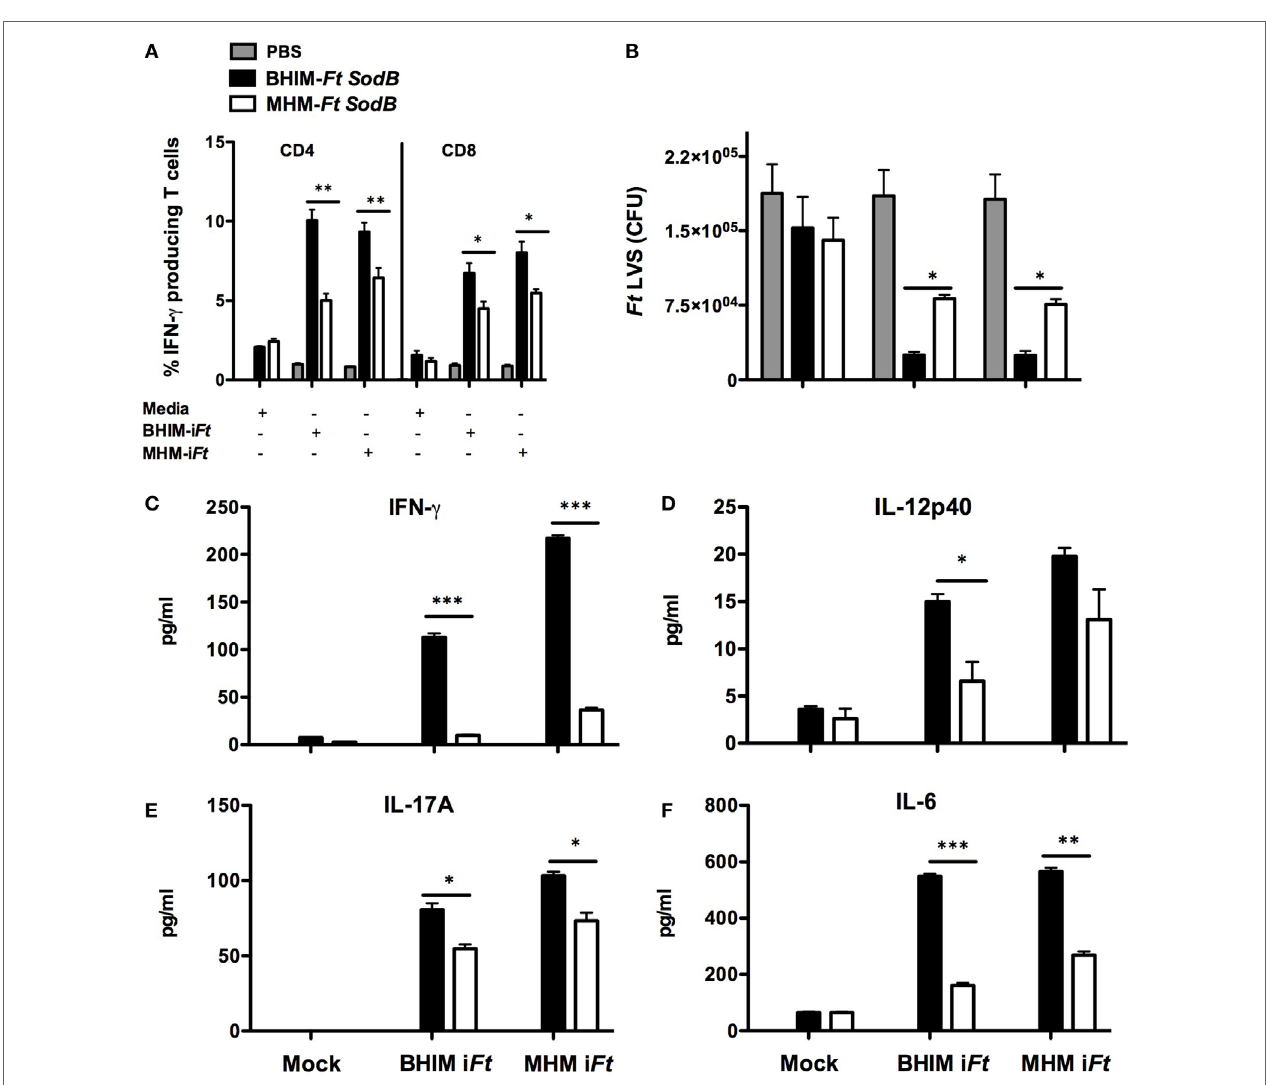
FigUre 8 | sodB-brain-heart infusion medium (BHIM)- Francisella tularensis ( Ft )-immunized mice exhibit superior memory recall response. C57BL/6 female mice were immunized with BHIM or Mueller-Hinton medium (MHM)- Ft sodB mutant as described in Figure 4 . Single-cell suspensions of splenocytes from PBS or sodB -mutant immune mice ( n = 3) were stimulated overnight with BHIM or MHM-i Ft. The percentage of IFN- γ -producing CD4 + and CD8 + T cells was visualized by FACS (a) . Ft LVS was added to BMDM cultures containing PBS, BHIM- Ft sodB , or MHM- Ft sodB -immune splenocytes and stimulated overnight with BHIM or MHM-i Ft . The BMDMs were then lysed 72 h post-infection, diluted 10-fold, and plated on MH-chocolate agar plates to determine intracellular bacterial replication (B) . The accumulated levels of IFN- γ (c) , IL-12p40 (D) , IL-17A (e) , and IL-6 (F) in these cultures were quantified. The data presented are representative of two independent experiments. * p < 0.05, ** p < 0.01, and *** p <